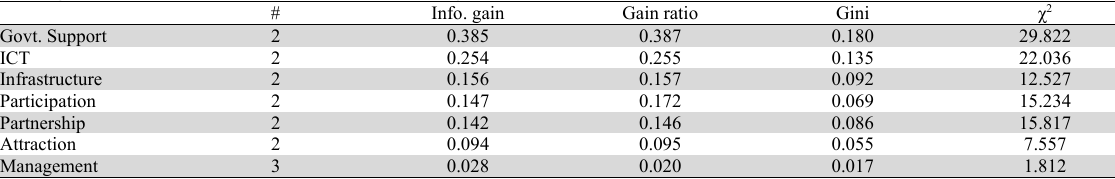
Ranking of Determinants Factors of Tourist Village